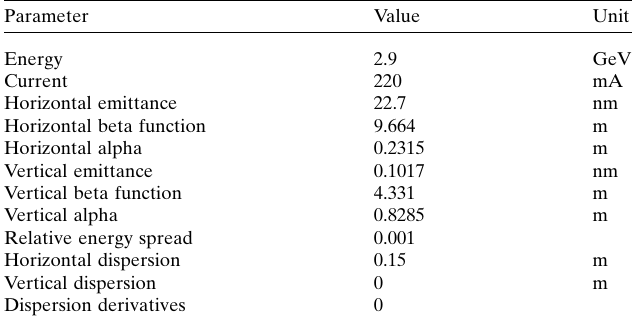
Table 2 Electron beam characteristics defined 2.125 m upstream of the centre of the ID straight section in the CLS storage